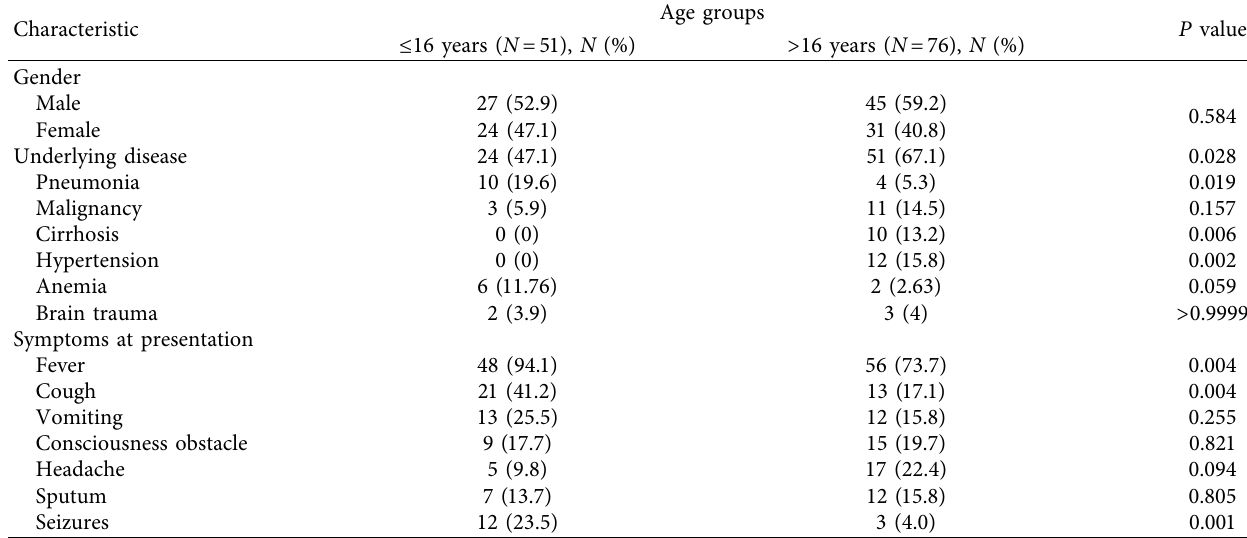
Table 1: Comparison of demographic and clinical characteristics between pediatric and adult IPD cases in Ningxia Hui Autonomous Region, China,